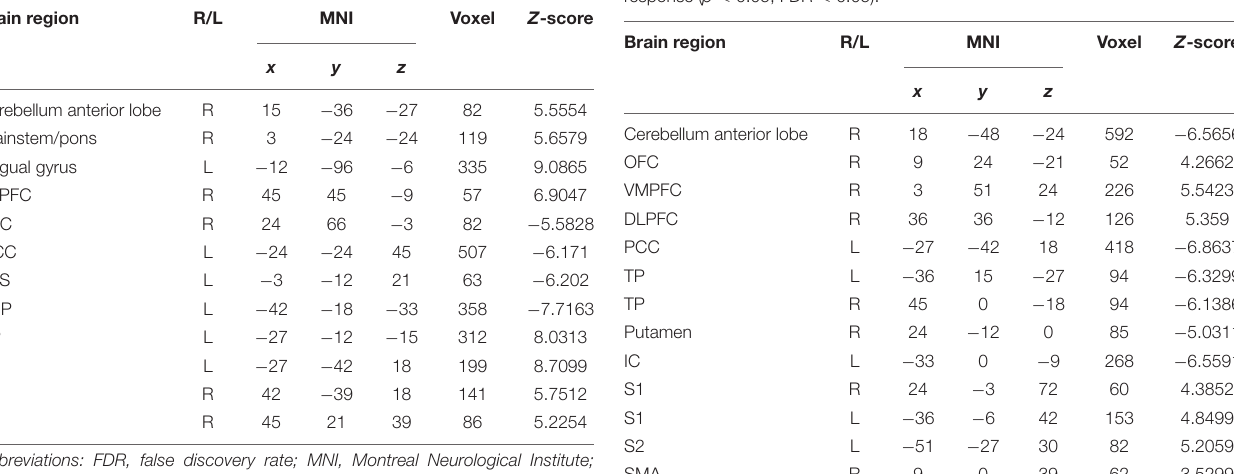
TABLE 7 | Summary of the brain areas showing functional connectivity with the rACC in comparison of male participants and female participants in nocebo response ( p < 0.05, FDR < 0.05).